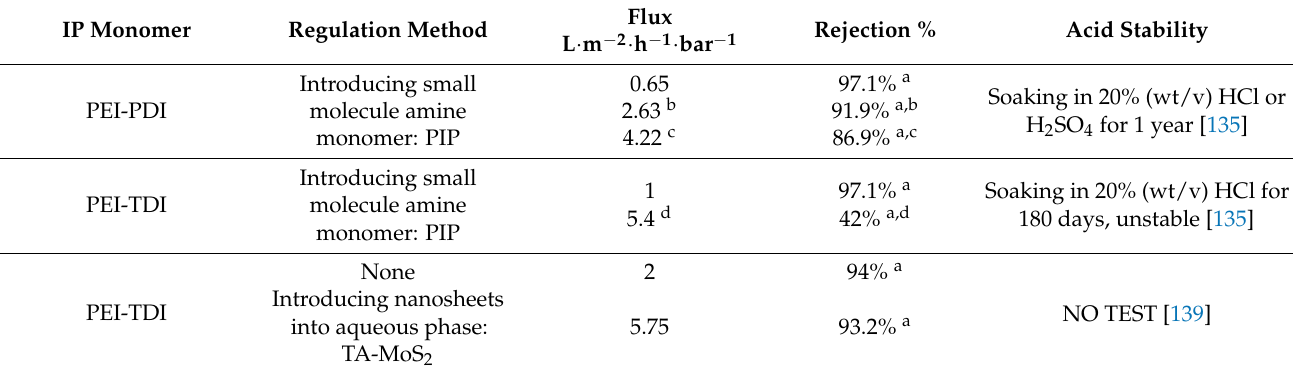
Table 4. Regulation method and acid stability of PU NF